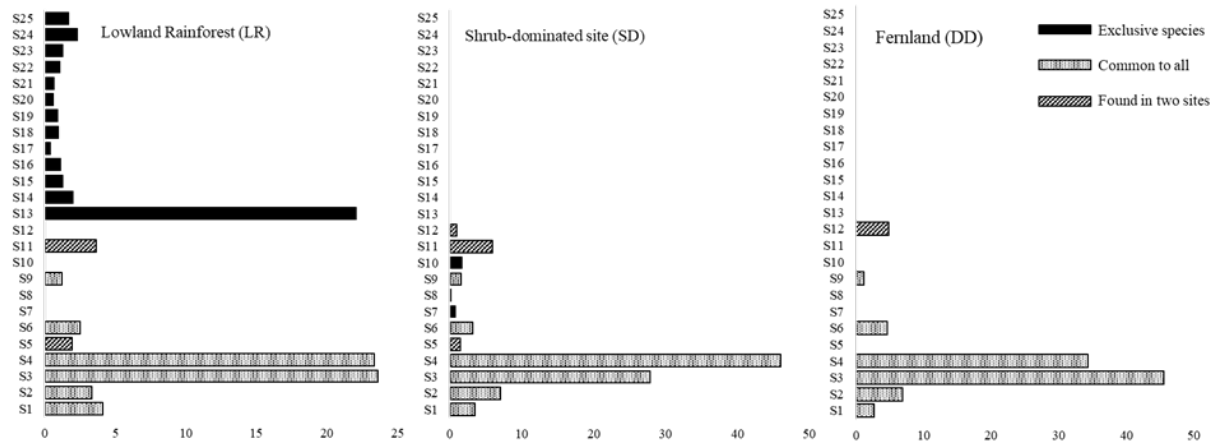
Figure 5: The relative abundance (as a %) of AMF morphotypes in three land use types; Lowland rain forest (LR), shrub-dominated site (SD) and Dicranopteris -dominated fernland (DD) in Kanneliya Forest Reserve in the Sri Lanka.